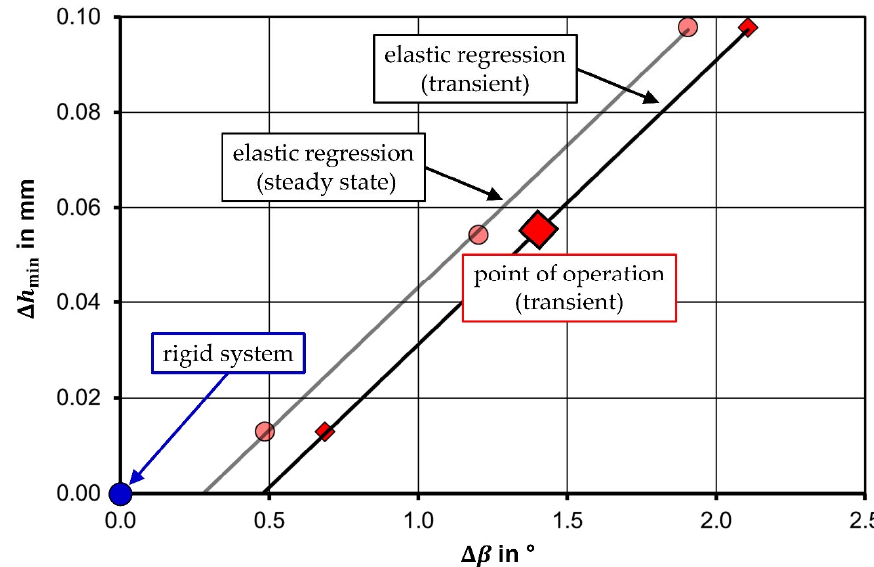
Figure 5. Elastic behavior of the Couette apparatus: rigid system vs. elastic system with increased film thickness ∆ h min and elastic lateral displacement of minimum film thickness ∆ β during the introduction of a radial displacement of the cavity 2 while the cylinder 1 rotates with constant rotating speed ω 1 .